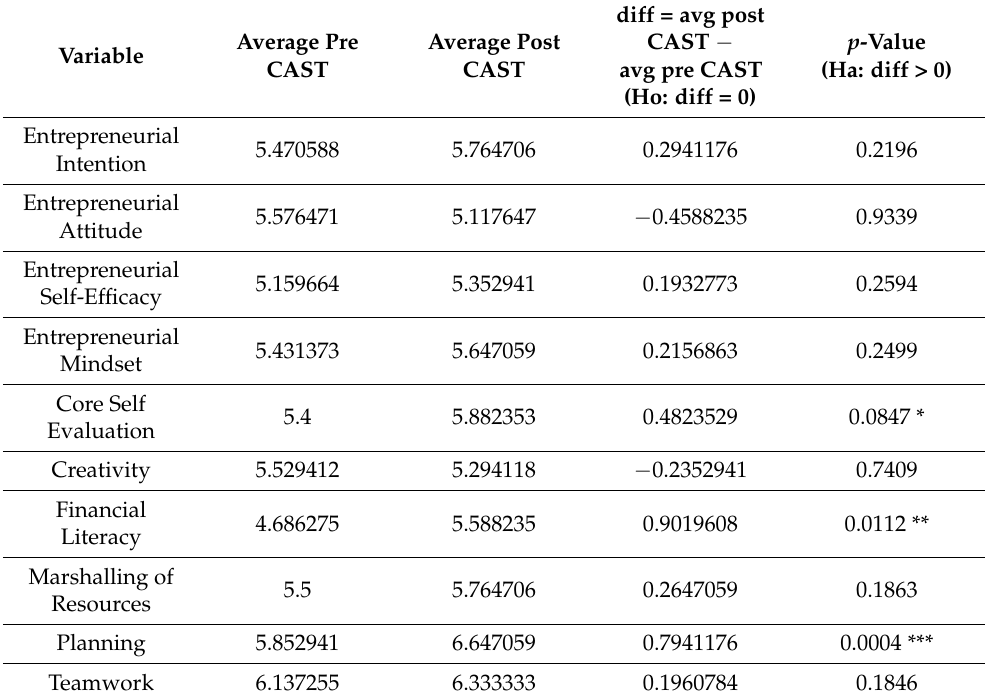
Table A6. Output of t -tests on entrepreneurial characteristics, pre- and post-course, of the students who had had at least one experience in practical entrepreneurship programs.